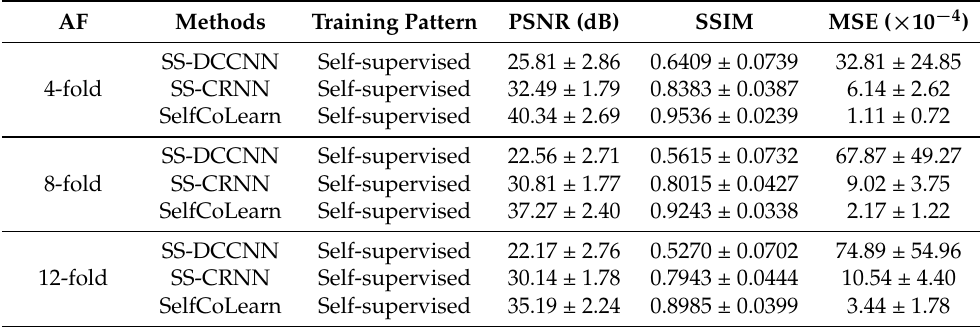
Figure 2. Reconstruction results of different self-supervised methods (SS-DCCNN, SS-CRNN, and SelfCoLearn) at 4-fold acceleration, 8-fold acceleration, and 12-fold acceleration. The first row and fourth row show the ground truth (fully sampled image) and the reconstruction images of the respective methods in the diastolic (the 10th frame of image sequence) and systolic (the 5th frame of image sequence), respectively. The second row and fifth row show their corresponding enlarged images in the heart regions. The third row and sixth row plot the error images of corresponding methods. The last two rows show y-t images (the 40th slice along the dimensions of y and t) and the corresponding error images. Table 1. Quantitative reconstruction results of different self-supervised methods (SS-DCCNN, SS- CRNN, and SelfCoLearn) at 4-fold, 8-fold, and 12-fold acceleration factors (mean ±